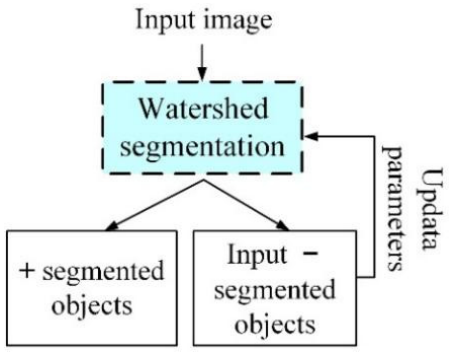
Figure 6. The flow diagram of MWES algorithm.